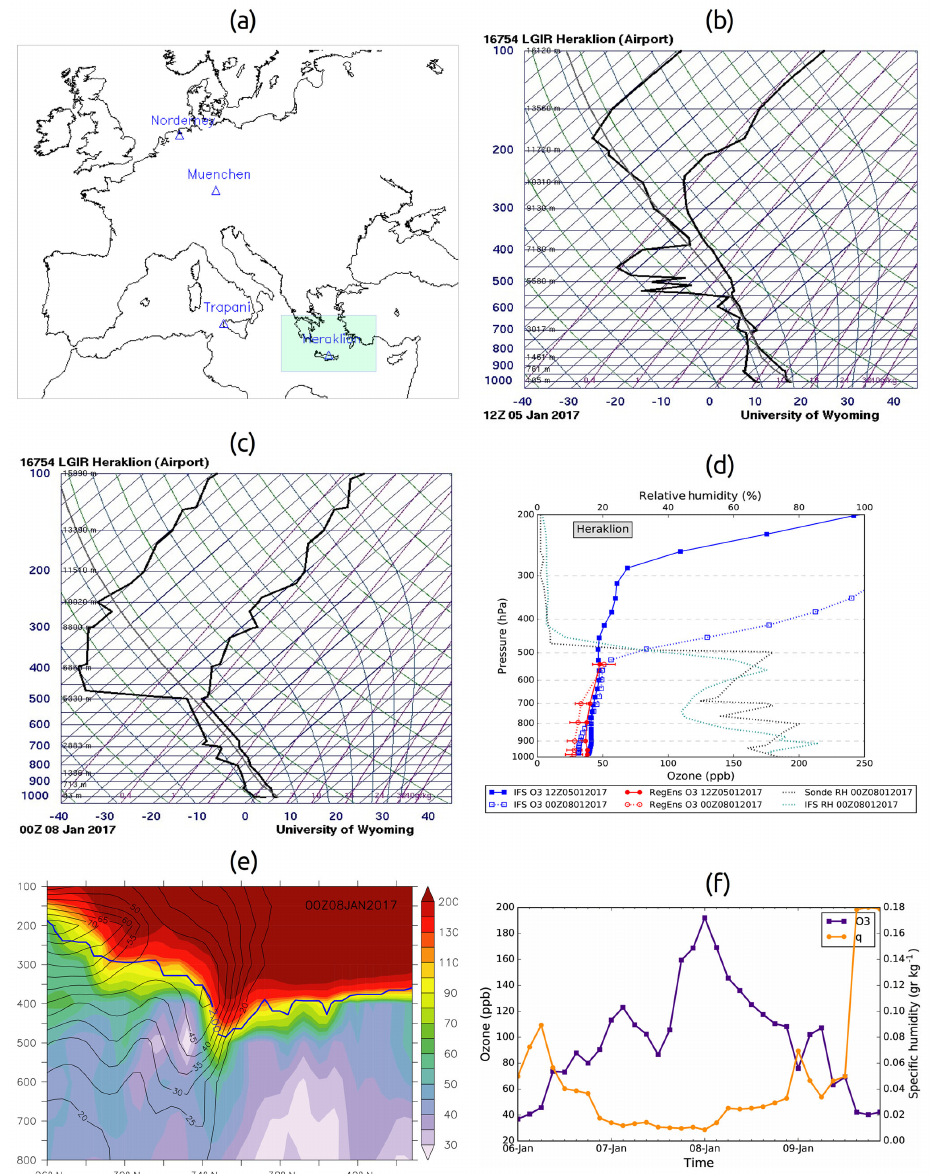
Figure 9. (a) Heraklion, Greece location. (b) Skew-T log-P diagrams at 12:00Z on 5 January 2017 and (c) 00:00Z on 8 January 2017. (d) Vertical profiles of IFS (blue) and RegEns (red) ozone mixing ratio (ppb) at 12:00Z on 5 January 2017 (solid line) and 00:00Z on 8 January 2017 (dashed line). The red bars denote the standard deviation among the regional ensemble members. Also shown are sonde (dashed black line) and IFS relative humidity (dashed cyan line) at 00:00Z on 8 January 2017. (e) Latitude–pressure vertical cross section at 25.2 ◦ E of IFS ozone mixing ratio (in ppb; colour shaded), wind speed (in ms − 1 ; black contours) and PV (2pvu; blue contours) at 00:00Z on 8 January 2017. (f) IFS ozone (blue) and specific humidity (orange) time series at